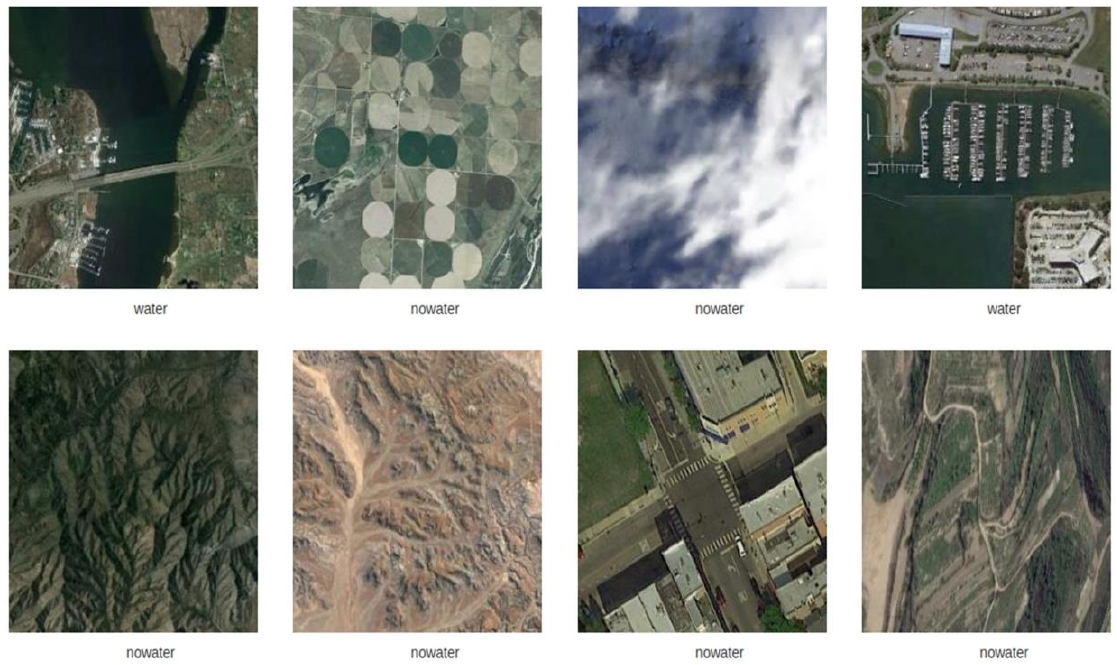
Figure 5. Video scene classification output classes from the test Video.